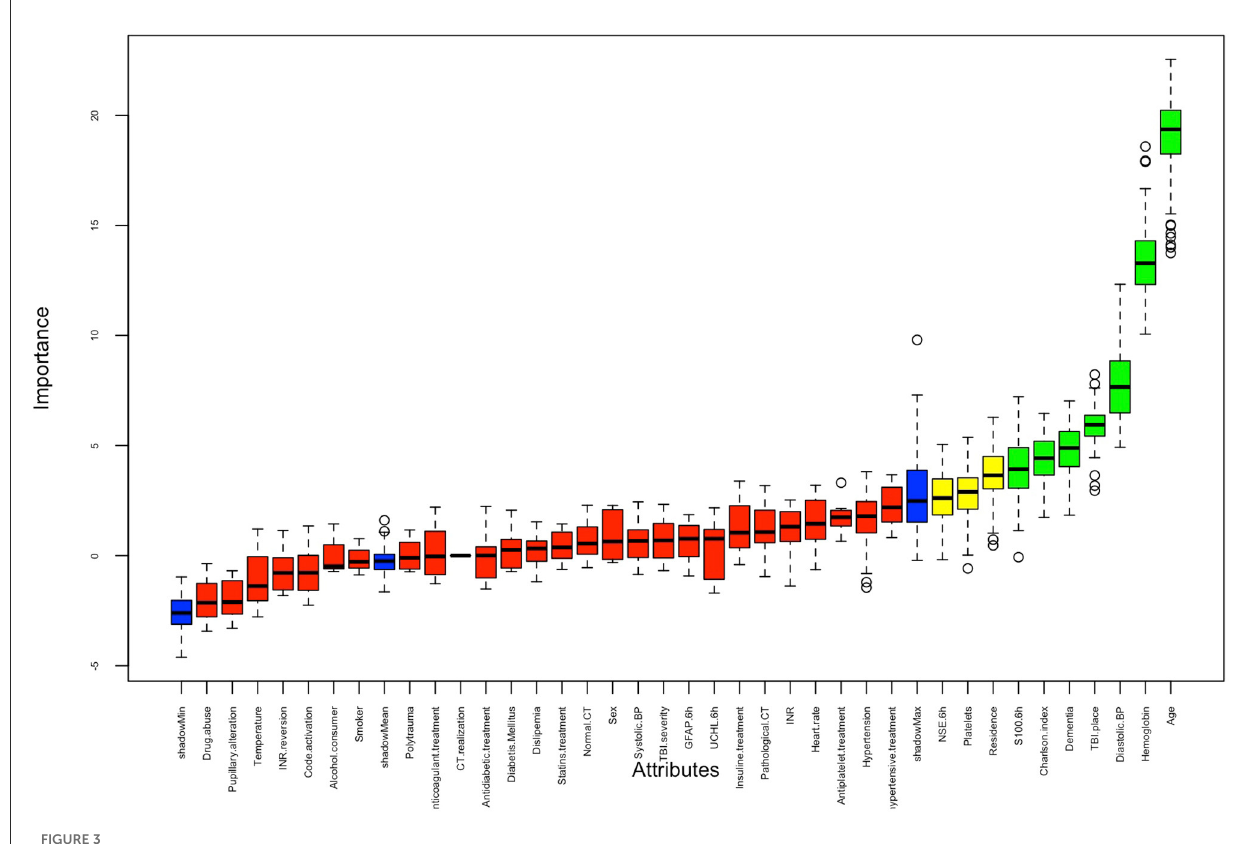
FIGURE3 Borutha algorithm to select explanatory variables.